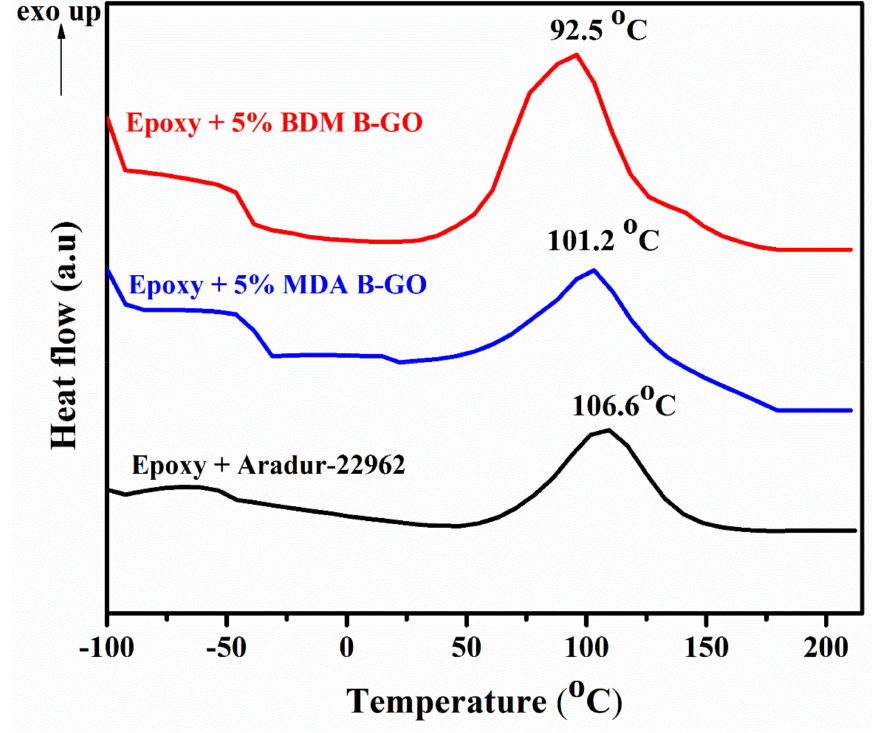
Figure 3. DSC thermograms of epoxy with oligoimides MDA-B-GO and BDM-B-GO with heating rate of 10 ◦ C